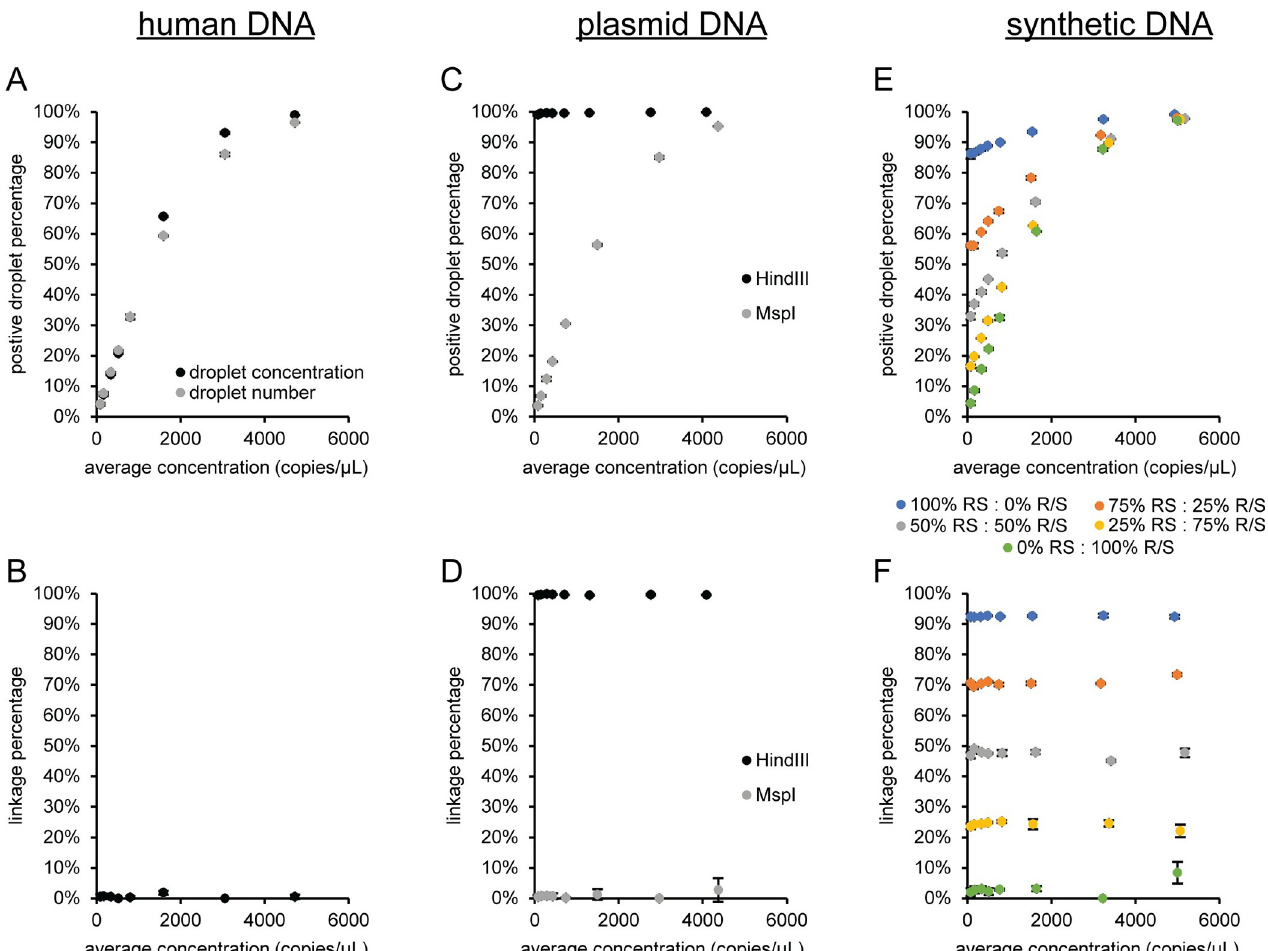
Fig 9. Comparison of genome integrity methods. Female DNA with HaeIII was used as a template for duplex ddPCR reactions using RPP30 FAM and SOD1 HEX and the data was analyzed as (A) the percentage of double positive droplets or (B) linkage percentage. (C and D) Plasmid pAV-CMV-GFP with either HindIII or MspI using CMV-Enh FAM and eGFP HEX assays and (E and F) synthetic DNA with HaeIII using RPP30 FAM and SOD1 HEX assays were analyzed correspondingly. The means and standard deviations are indicated. The standard deviations are smaller than the marker when not visible. RS: gBlock with RPP30 and SOD1 target sequences that has no HaeIII site between the assays. R/S: gBlock with RPP30 and SOD1 target sequences on the same molecule with a single HaeIII site between the